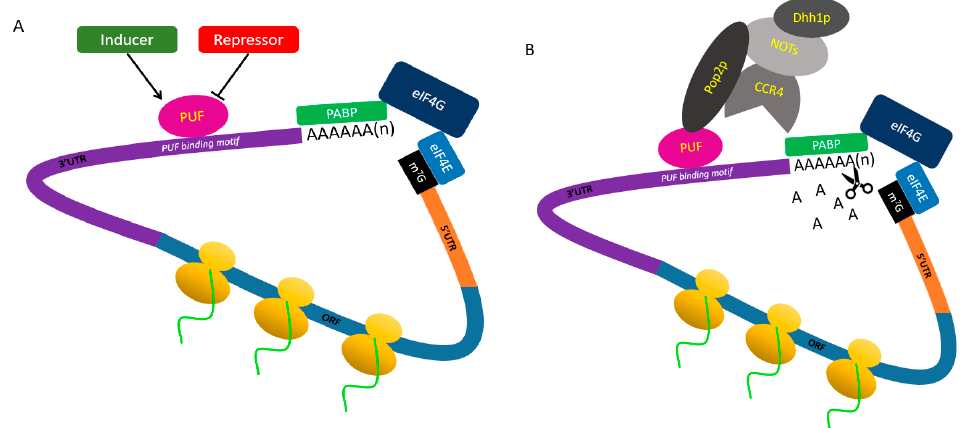
Figure 2. The common model of PUF protein influences mRNA stability. ( A ) Some genes regulate the expression or binding efficiency of PUF proteins in nucleus and/or in cytoplasm; ( B ) The PUF protein can bind to the PUF binding motif, which is located in the 3 ′ UTR of target gene, and recruit the CCR4-POP2-NOT complex through interacting with Pop2 (the subunit of CCR4-POP2-NOT complex). The CCR4-POP2-NOT complex acts as a deadenylase in cell. It can affect the mRNA stability by reducing the length of poly(A) tail. Meanwhile, Dhh1p (DExD/H-box ATP-dependent RNA helicase), which can interact with CCR4-POP2-NOT complex, acts on the cap to activate decapping and inhibit translation [60].